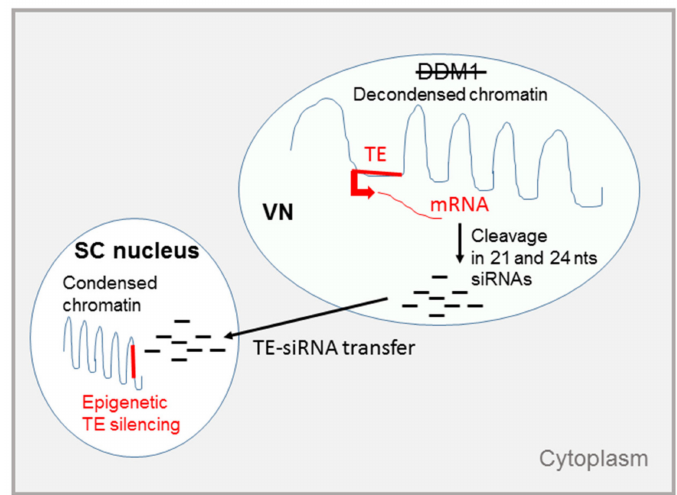
Figure 3. The potential role of siRNAs in the Arabidopsis male gametophyte. In the VN, the chromatin is in a decondensed state due to a lack of the chromatin remodeling protein DDM1. The transcription of TEs is allowed and gives rise to mRNAs that are cleaved in 21- and 24-nt siRNAs. These siRNAs may get out of the VN and enter the neighboring sperm cell where they direct DNA methylation of complementary TEs or genes. DNA is in blue, TEs and their mRNAs are in red. Cell-to-cell movement is indicated by an